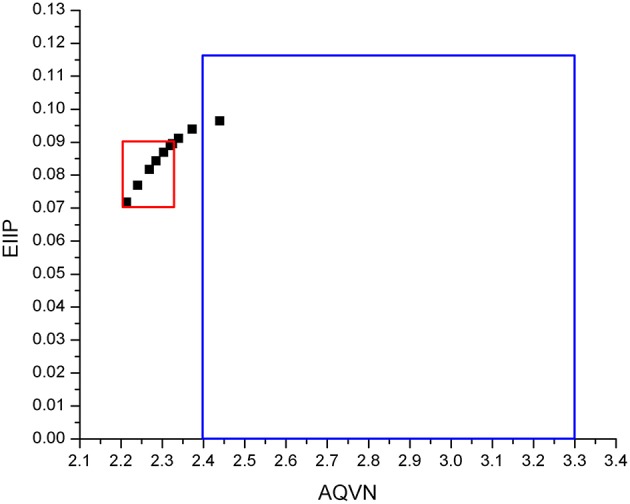
Schematic presentation of the EIIP/AQVN criterion for selection of candidate M2 inhibitors. Common domain of active compounds for both WT and S31N M2 (red) with AQVN (2.21–2.32), EIIP (0.071–0.089). Chemical space (blue) with AQVN (2.40–3.30) EIIP (0.000–0.116)—EIIP/AQVN domain of homologous distribution of >90% compounds from PubChem Compound Database.